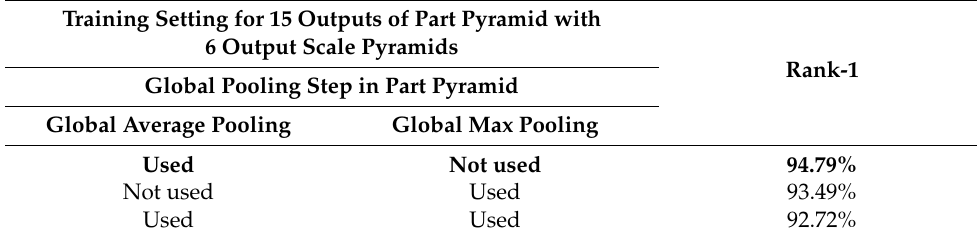
Table 3. Configuration evaluation result for part pyramid block. Training Setting for 15 Outputs of Part Pyramid with